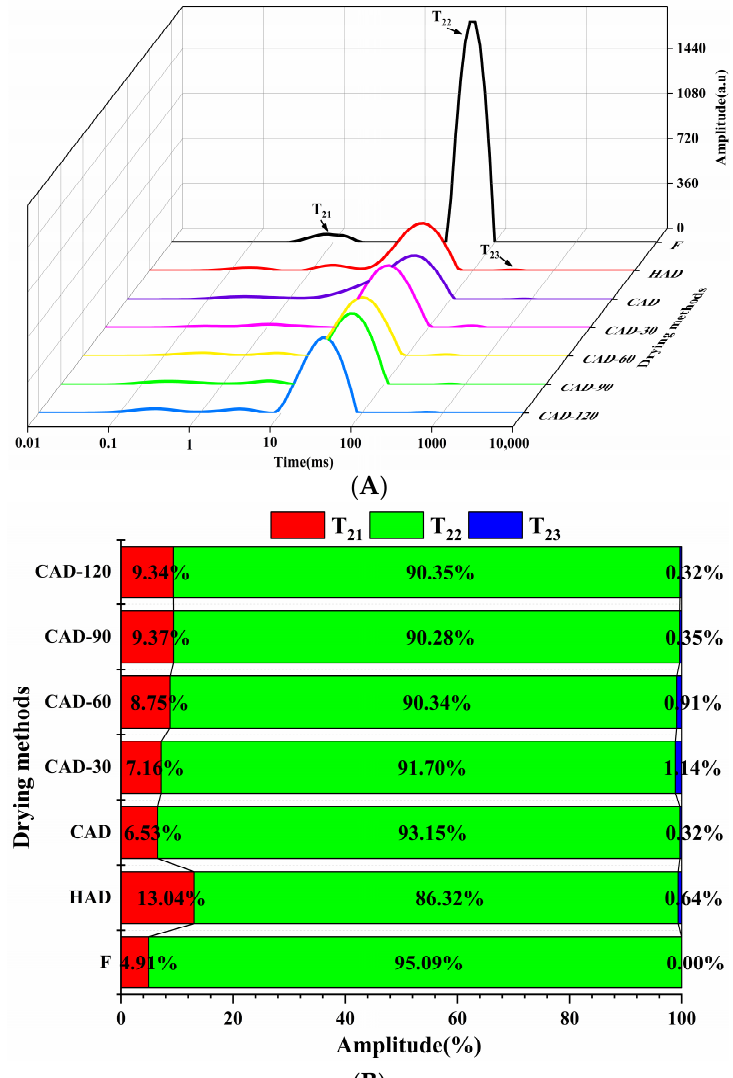
Figure 2. Curve of T 2 transverse relaxation time ( A ) and proportion of various peak areas ( B ) in semi-dried pufferfish fillets. F, fresh undried fillets; HAD, hot air drying; CAD, cold air drying; CAD-30, cold air drying for 30 min; CAD-60, cold air drying for 60 min; CAD-90, cold air drying for 90 min; CAD-120, cold air drying for 120 min.